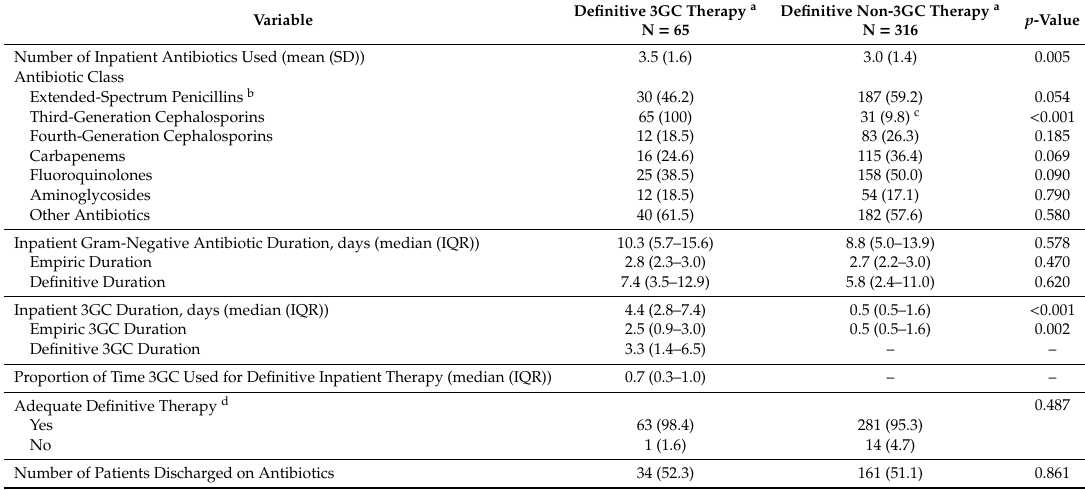
Table 3. Antibiotic utilization by therapy group.